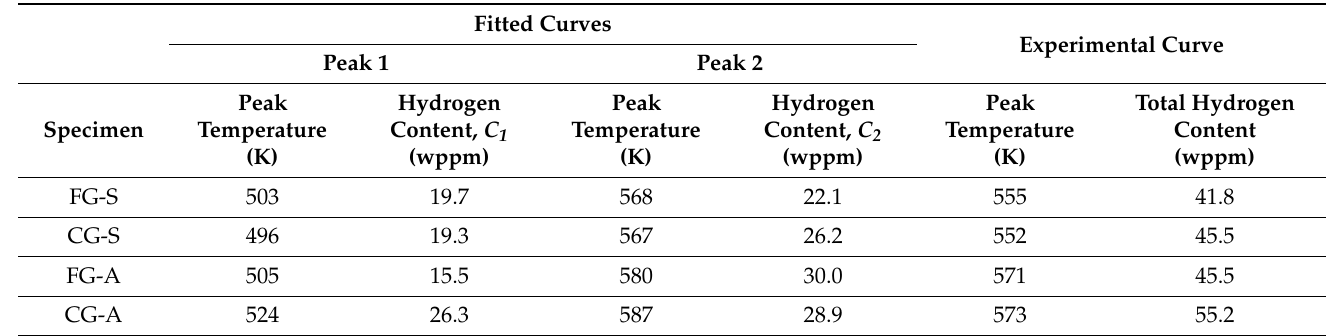
Table 2. Peak temperature and the absorbed hydrogen content acquired by experimental and fitted TDS